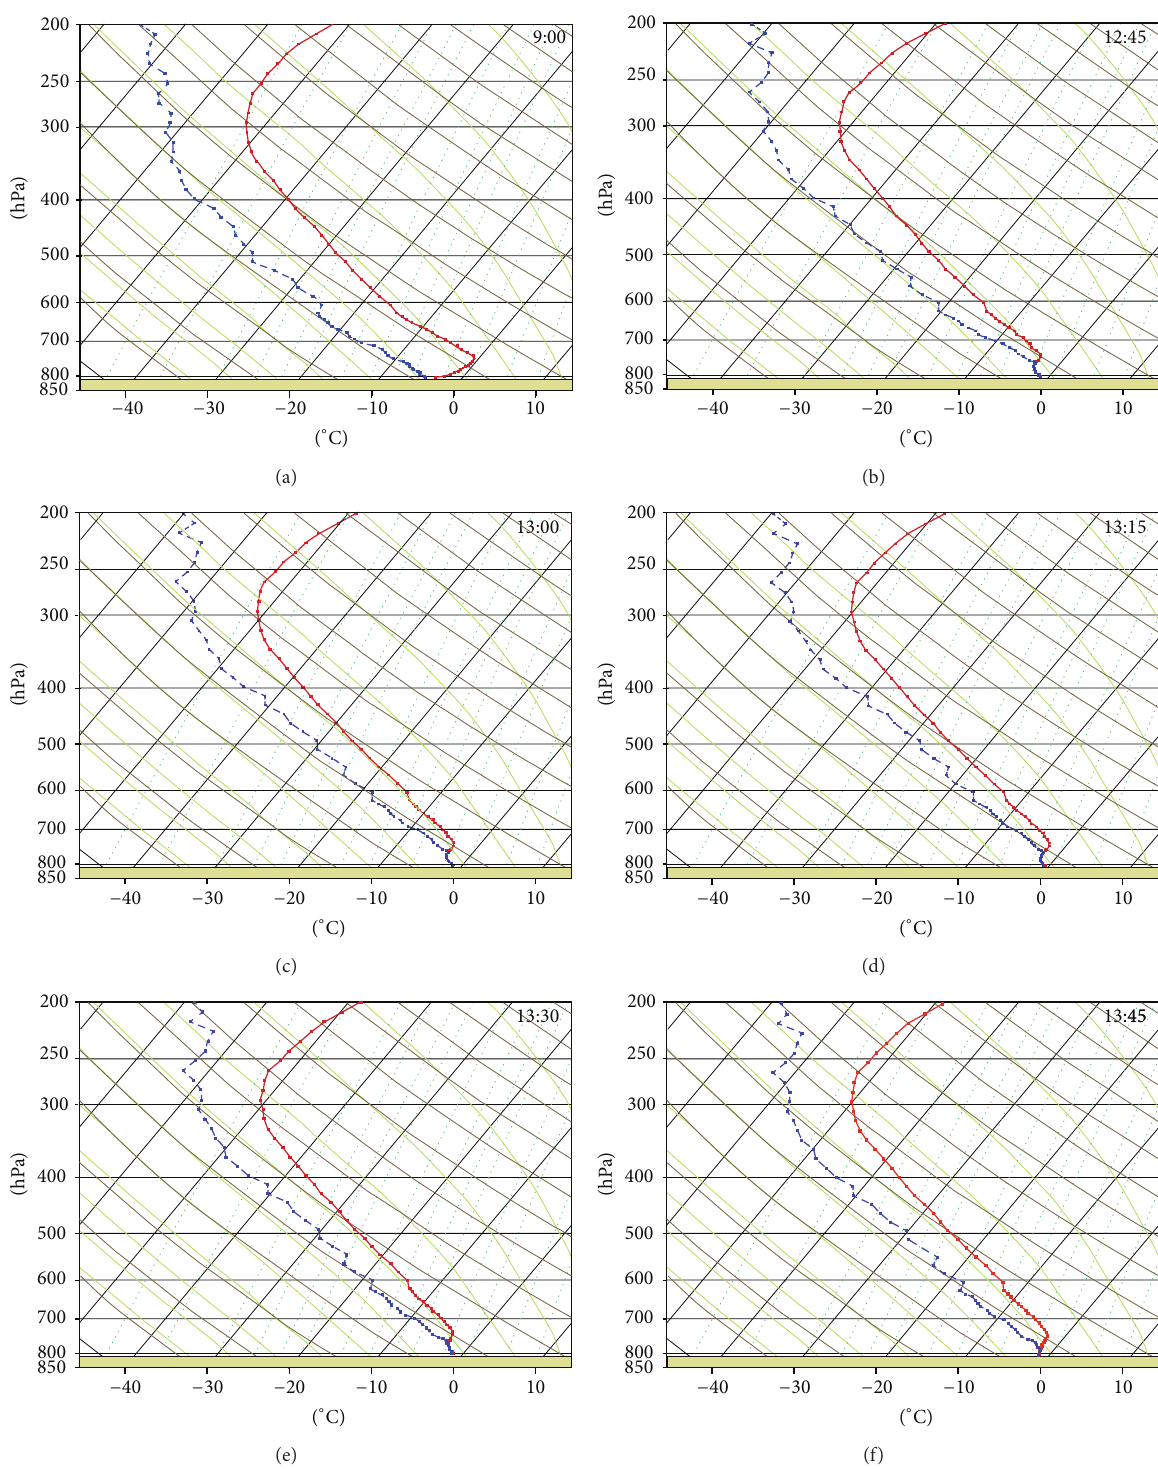
Figure 2: Skew-T/log-P diagram of radiometer data at 9:00, 12:45, 13:00, 13:15, 13:30, and 13:45 on February 1, 2012. Temperature (red lines); dew point (blue dashed